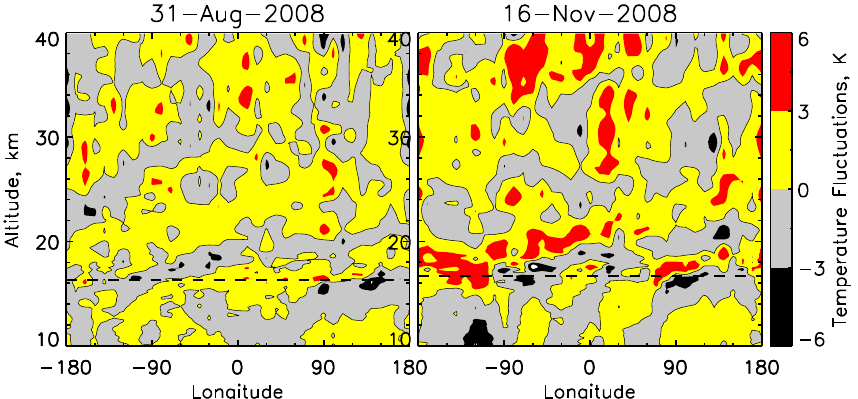
Fig. 4. Temperature fluctuations on 31 August 2008 and 16 November 2008 showing the vertical structure of the temperature fluctuations. Observe the large amplitudes on 16